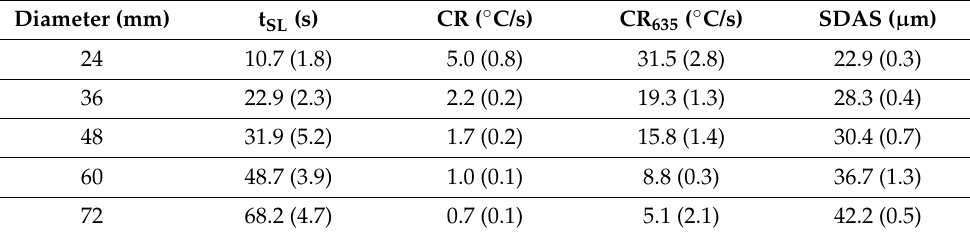
Table 5. Average values of t SL , CR, CR 635 and the experimentally measured SDAS for each test casting section (standard deviation values are shown between